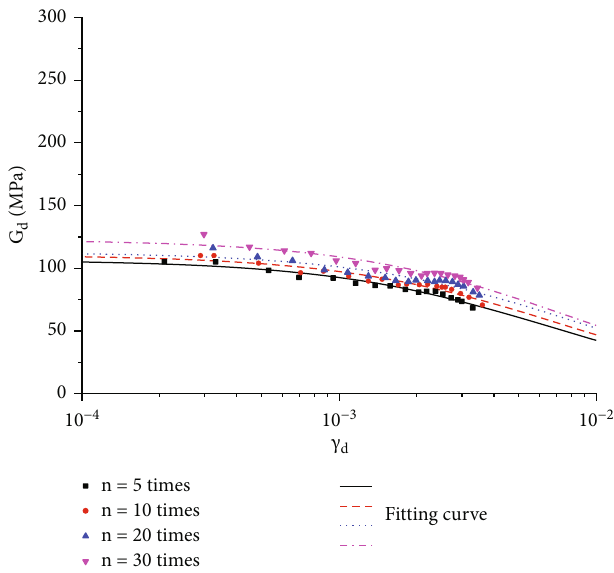
Figure 13: Dynamic shear modulus-strain curves under di ff erent freeze-thaw cycles (-5 °